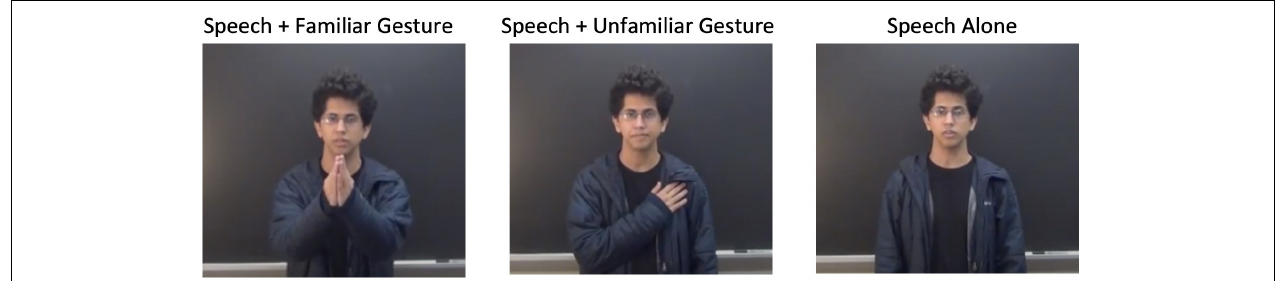
FIGURE 1 | Stimuli example from Experiment 1: Sorry ( duì bu